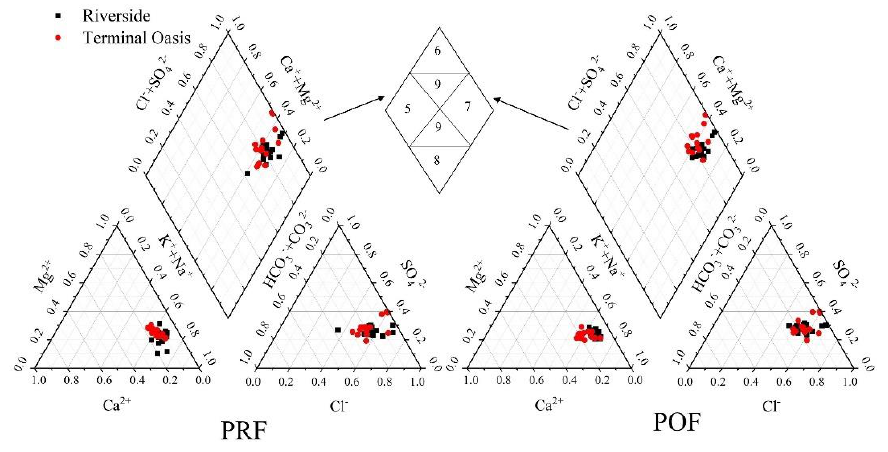
Figure 4. Groundwater piper trilinear map.